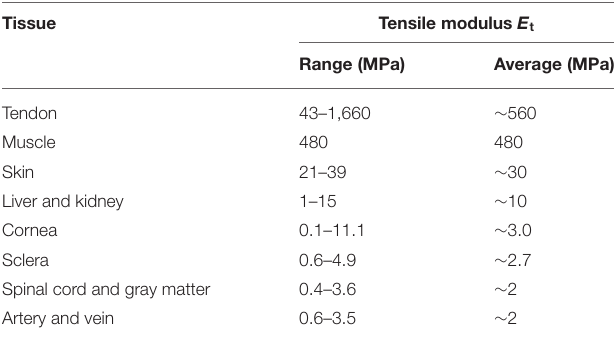
TABLE 6 | Tensile modulus of soft tissues found in literature, reproduced from McKee et al. [ 27].